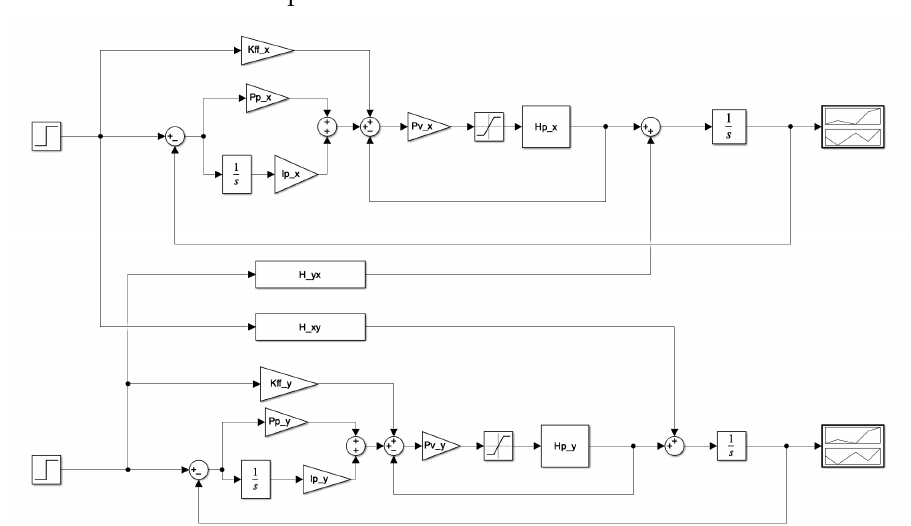
Figure 3. Cascade and feedforward configuration for the MIMO system.